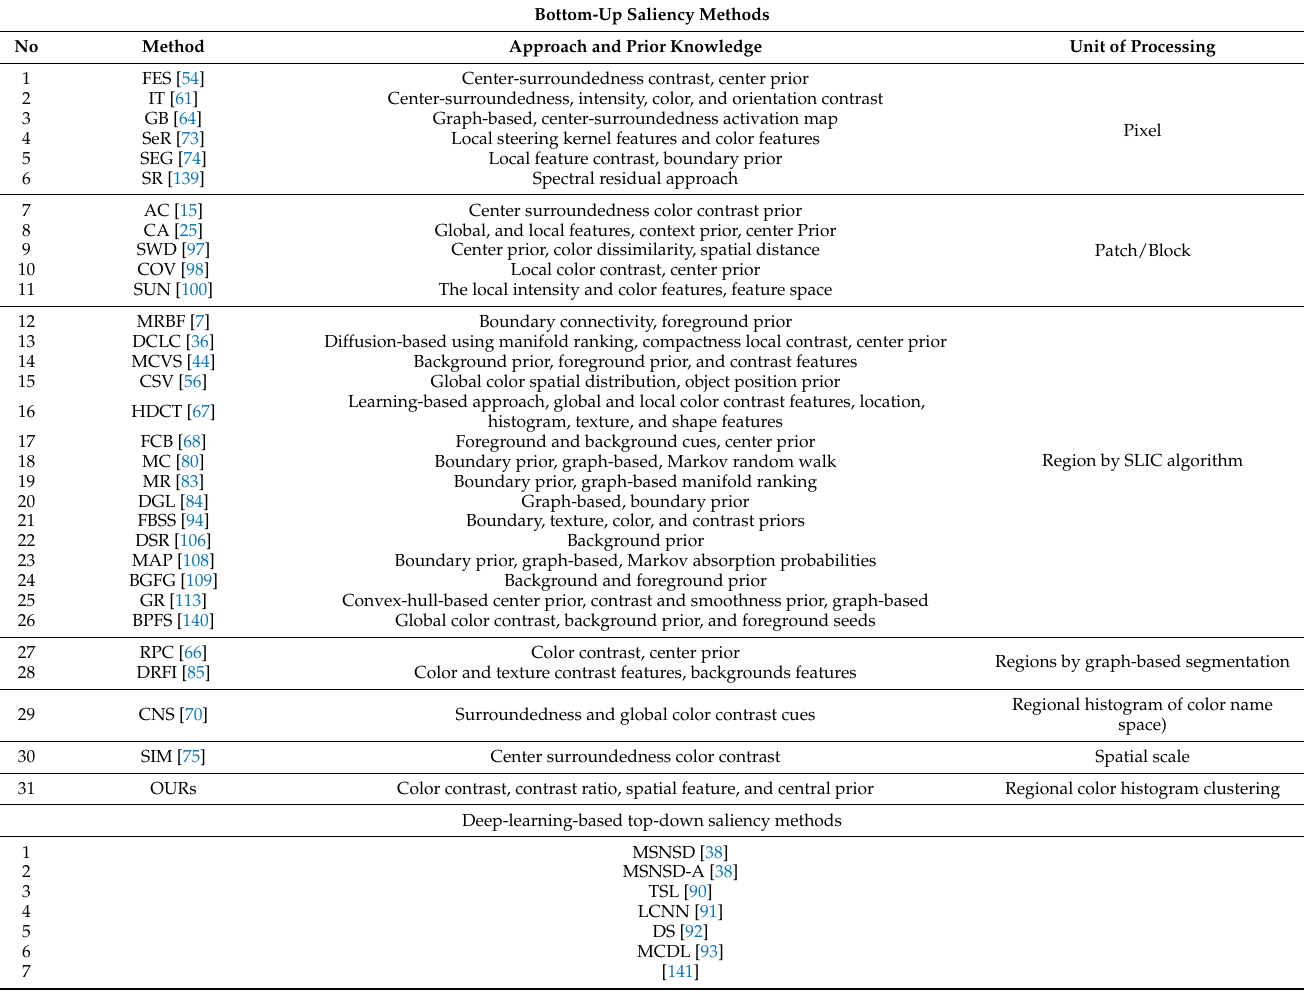
Table 1. Saliency methods